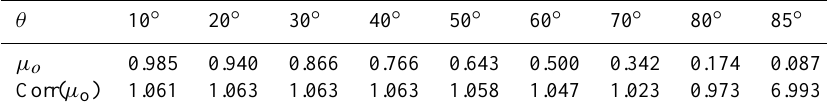
Table 2. The correction factor (Corr( µ o )) used in Eq. (13) and Eq. (15), where µ o =cosine of the solar zenith angle ( θ ).